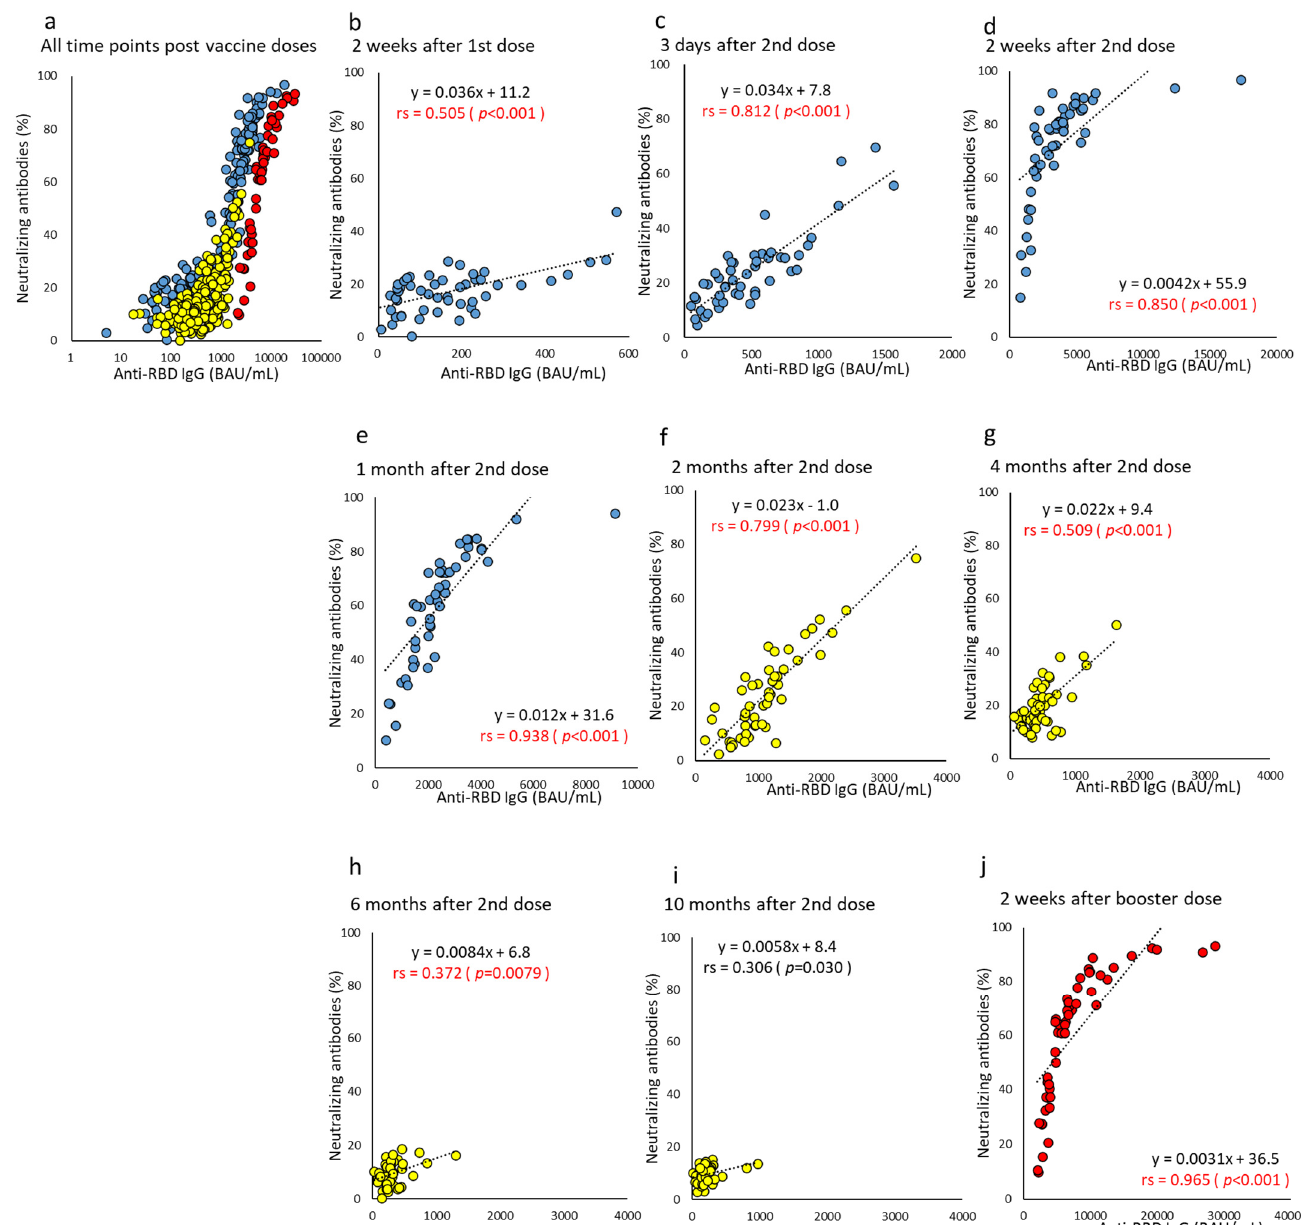
Figure 7. ( a – j ). Correlation at time points between anti-RBD IgG and neutralizing antibody after BNT162b2 vaccine doses. The levels of parameters indicating anti-RBD IgG and neutralizing antibodies of humoral immunity are plotted, and the correlation is compared using all or each time point post-vaccine doses. Antibody titers at all time points are indicated on a log scale ( a ). Time points until one month after two doses are represented by blue ( b – e ), from two months to 10 months after two doses are represented by yellow ( f – i ), and two weeks after the booster dose are represented by red ( j ). p -values were calculated using Spearman’s rank correlation test, and significance was set at 0.01. Red values indicate a significant correlation (rs, Spearman’s rank correlation coefficient).